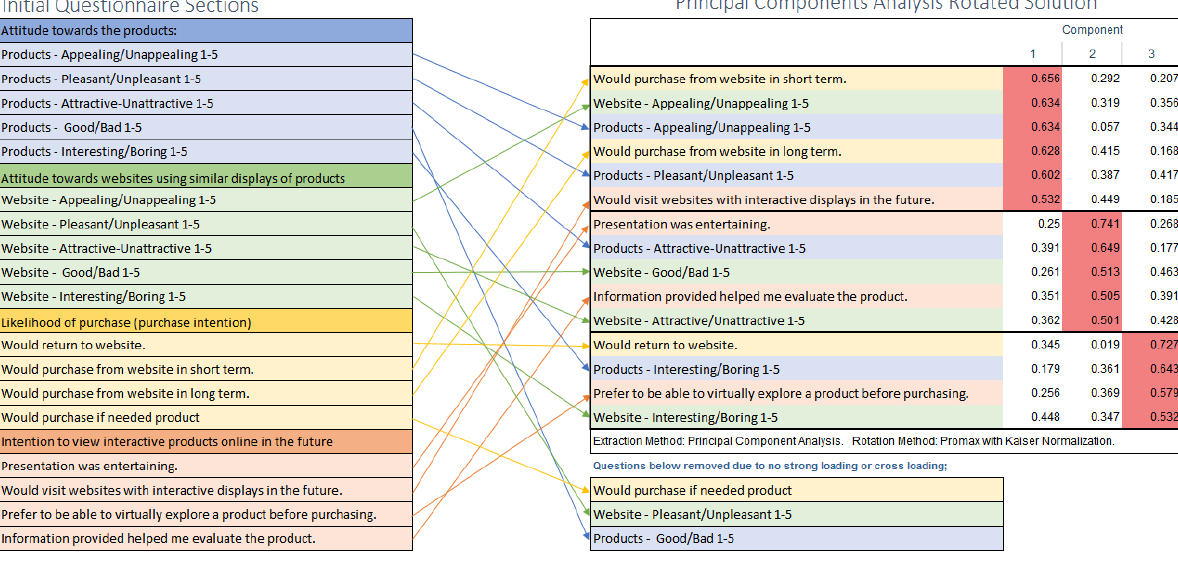
Figure A1. PCA Analysis.